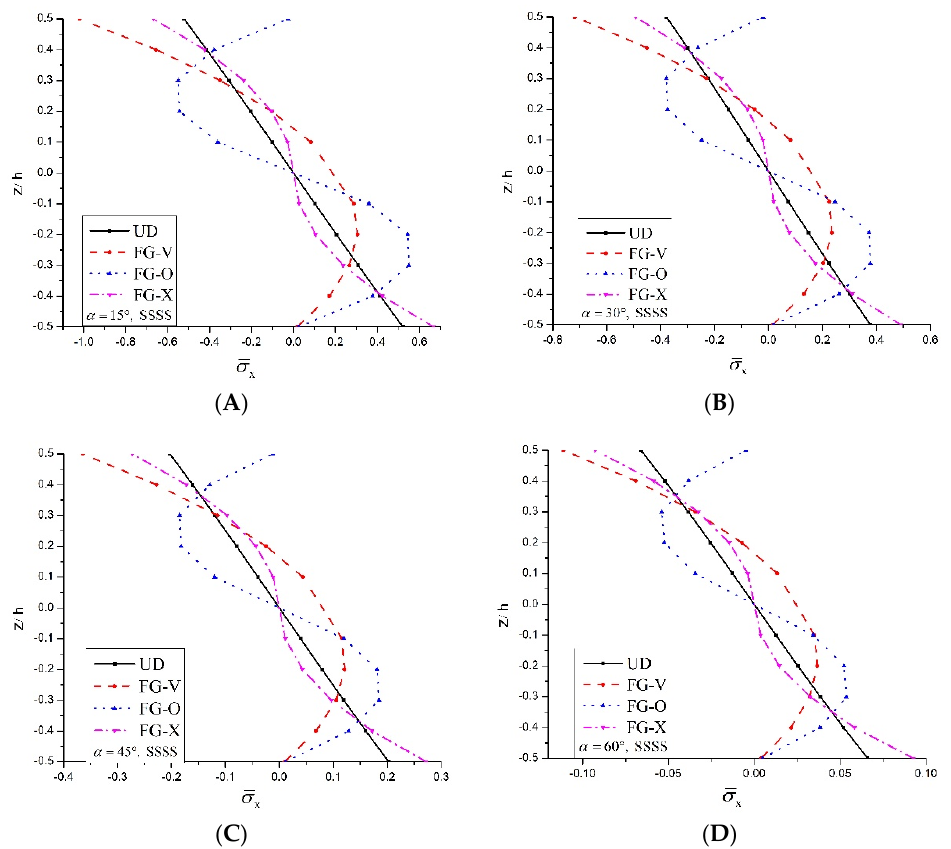
Figure 9. Variation of non-dimensional axial stress for FG-CNT-reinforced rhombic plate subjected to sin-sin loading for ( A ) α = 15 ◦ , ( B ) α = 30 ◦ , ( C ) α = 45 ◦ and ( D ) α = 60 ◦ .